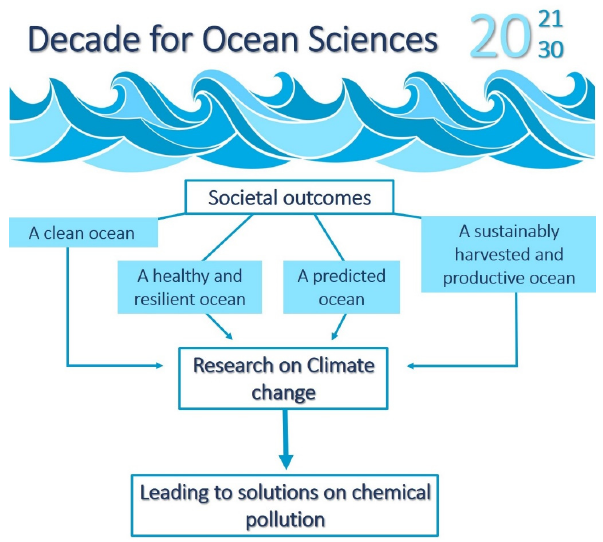
Figure 3. Societal outcomes set by the Decade of Ocean Sciences that are somehow related to climate change and marine pollution.